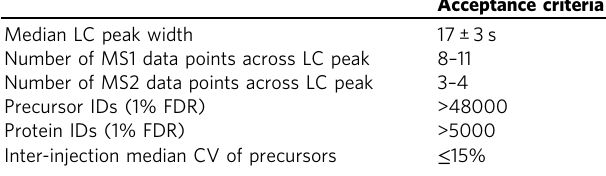
Table 1 Reference metrics and associated acceptance criteria from the system suitability QC tests.